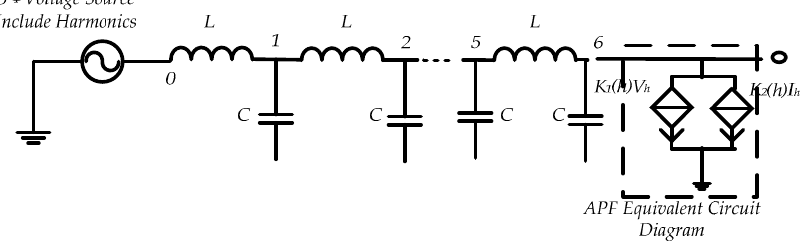
Figure 2. Transmission system model and equivalent active power filter (APF).